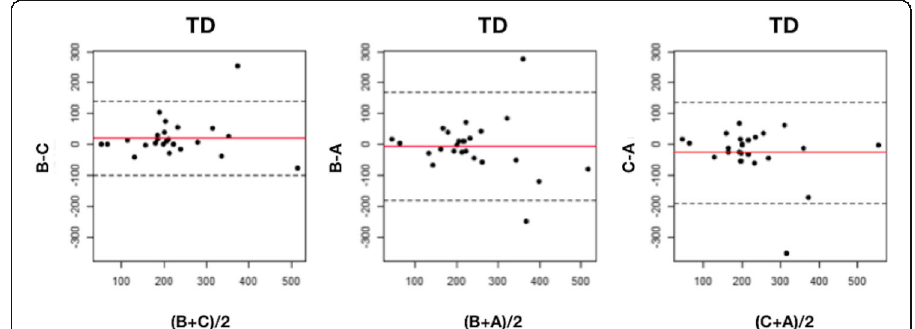
Fig. 4 Bland-Altman graph for tumoral doses (TD) in grays. The red line represents the average of the differences between observers and the dotted line, the mean of the differences ± 2 standard deviations